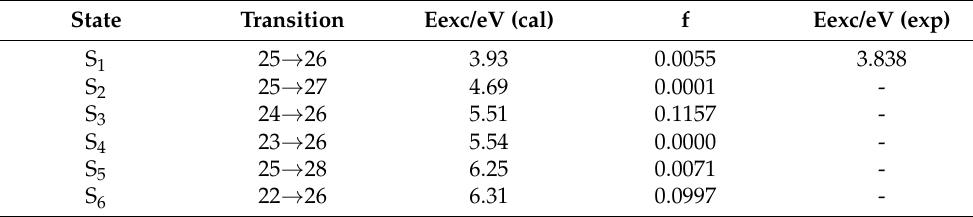
Table 1. Energies of electronically excited singlet states and corresponding oscillator strengths calculated by time-dependent density functional theory with a B3PW91/6-311++G (d, p) basis set. State